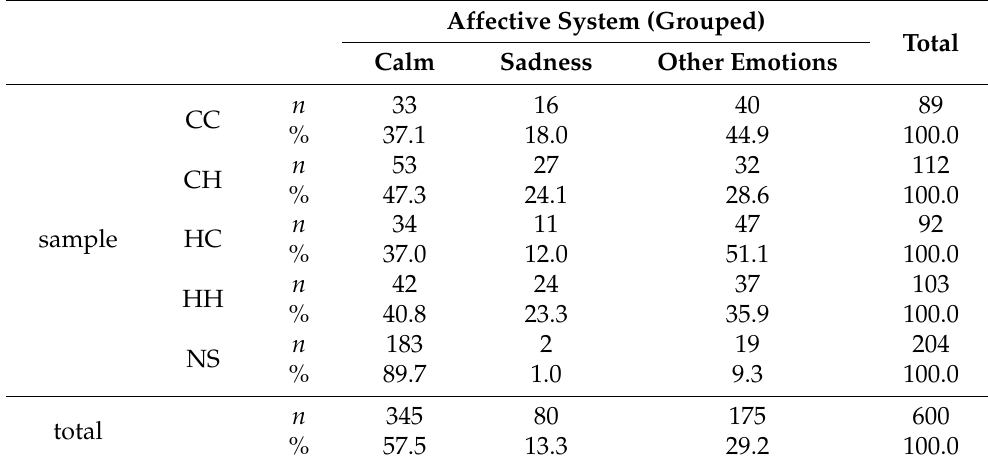
Table 6. Contingency table audio sample, affective system (grouped).